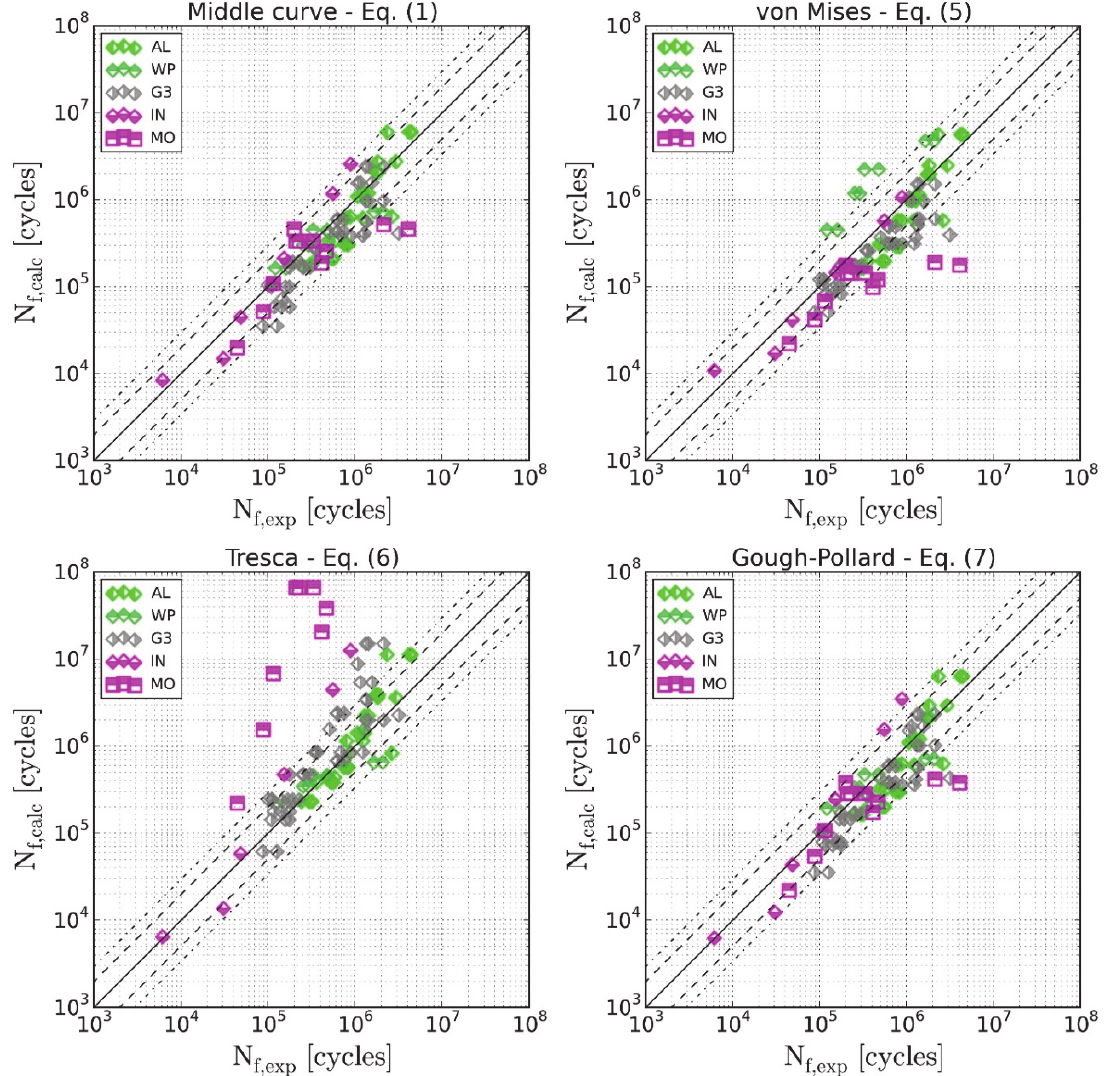
Figure 2: Comparison of experimental and predicted fatigue